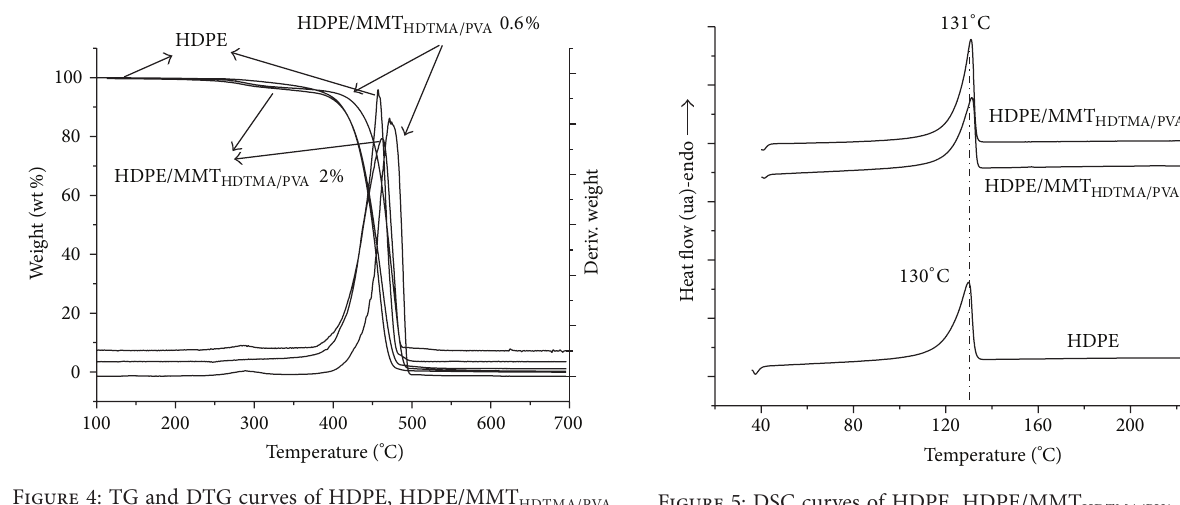
Figure 5: DSC curves of HDPE, HDPE/MMT 0.6wt%, HDTMA/PVA HDTMA/PVA 2wt%. 2wt%. and HDPE/MMT HDTMA/PVA HDTMA/PVA